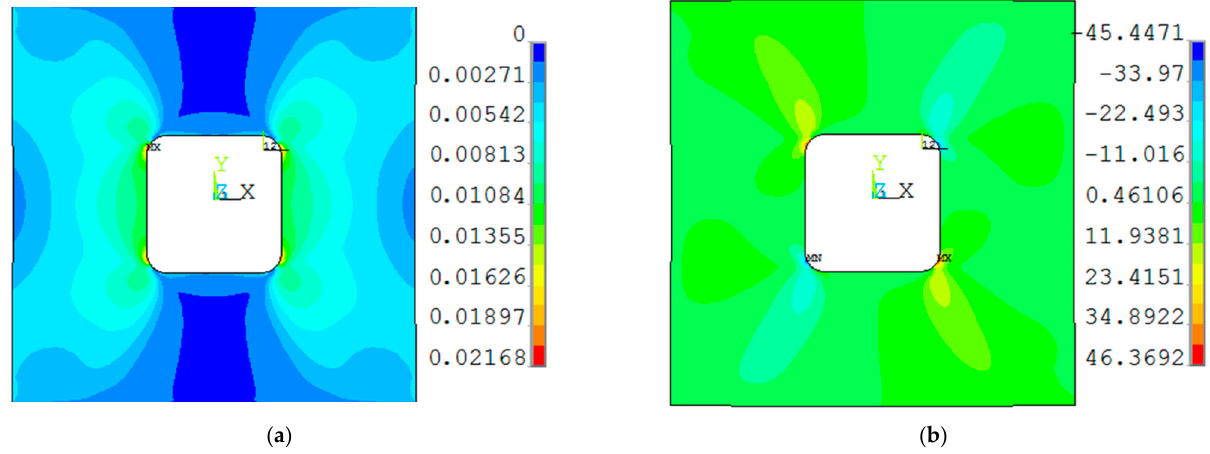
Figure 33. FE results for sample 5 with composite overlays, ε TOT = 0.57%: ( a ) vertical stress σ y in layer no. 19 (external surface); ( b ) shear stress in adhesive layer.